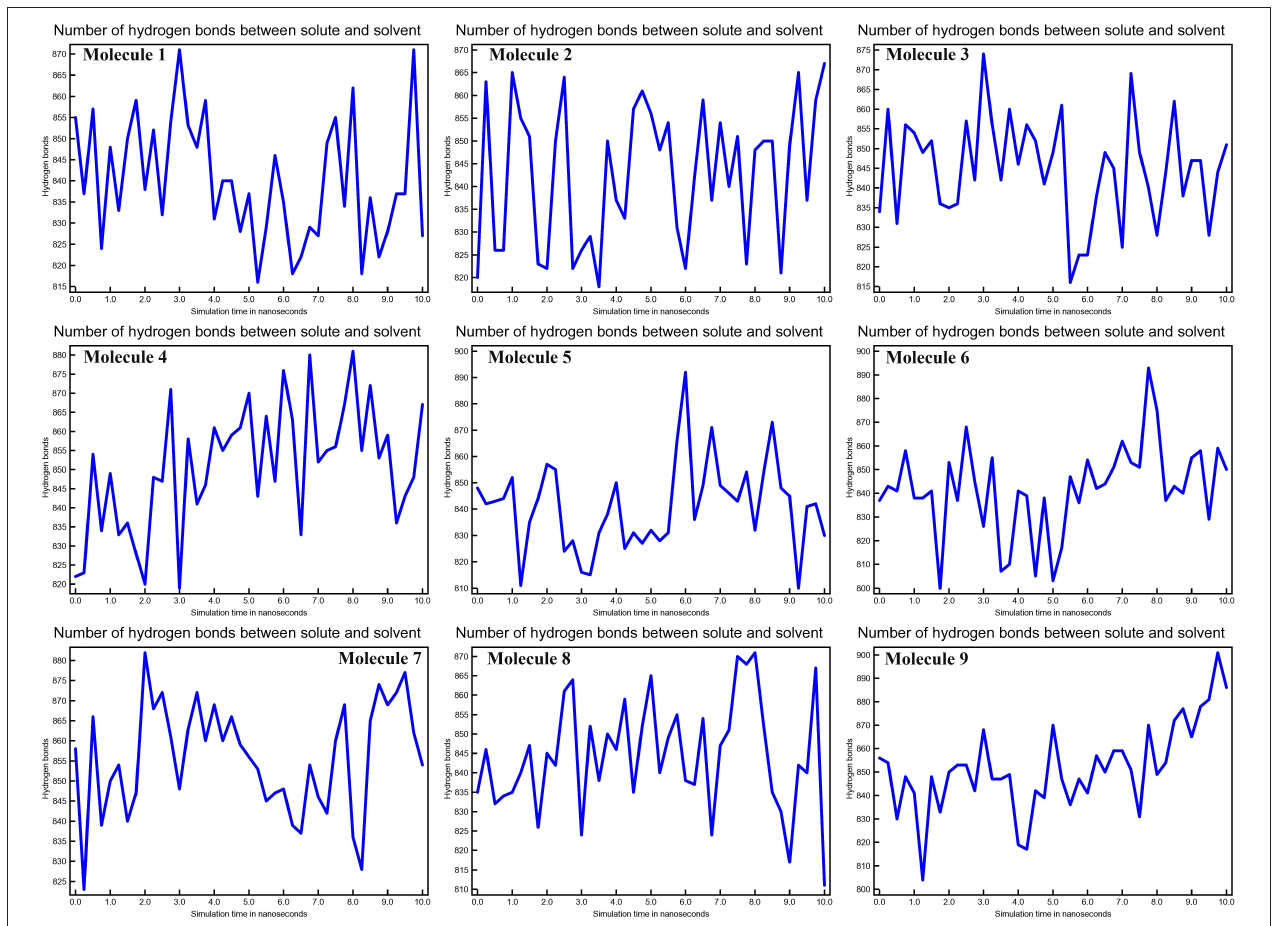
FIGURE 8 | Calculations of No. of H-bonds between solute and solvent of CYP51 and nine molecules as a function of 10 ns simulation